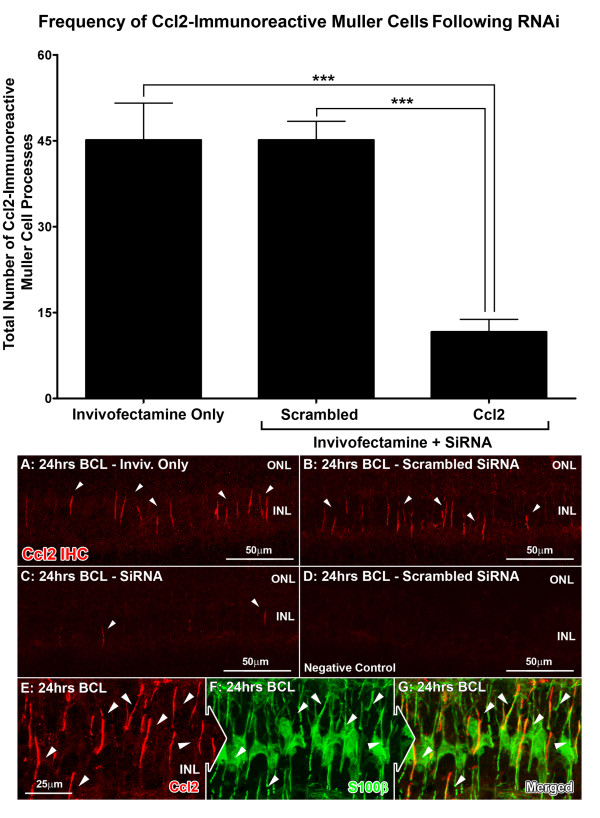
Immunoreactivity (IR) for chemokine (C-C motif) ligand (Ccl)2 protein in Müller cells following light damage in relation to Ccl2 small interfering (si)RNA treatment. (A–D) Representative images from the superior mid-periphery showed strong IR for Ccl2 (red) in radially oriented processes within the inner nuclear layer (INL) following (A–C) BCL (white arrows), whereas (D) negative controls showed no fluorescence. (E–G) The Ccl2 IR showed strong colocalization for S100B-immunoreactive (green) Müller cell processes (white arrows). The histogram of the quantification of Ccl2-IR Müller cell processes per retina indicated a substantial reduction in animals injected with Ccl2 siRNA (11.6, P < 0.05) compared with those injected with Invivofectamine only or with scrambled siRNAs (45.1 and 45.2 respectively). Inivofectamine-only (n = 4), scrambled siRNA (n = 4), Ccl2 siRNA (n = 4) Error bars represent SEM. *Significant change at P <0.05 using ANOVA with Tukey’s post hoc test. ONL, outer nuclear layer.